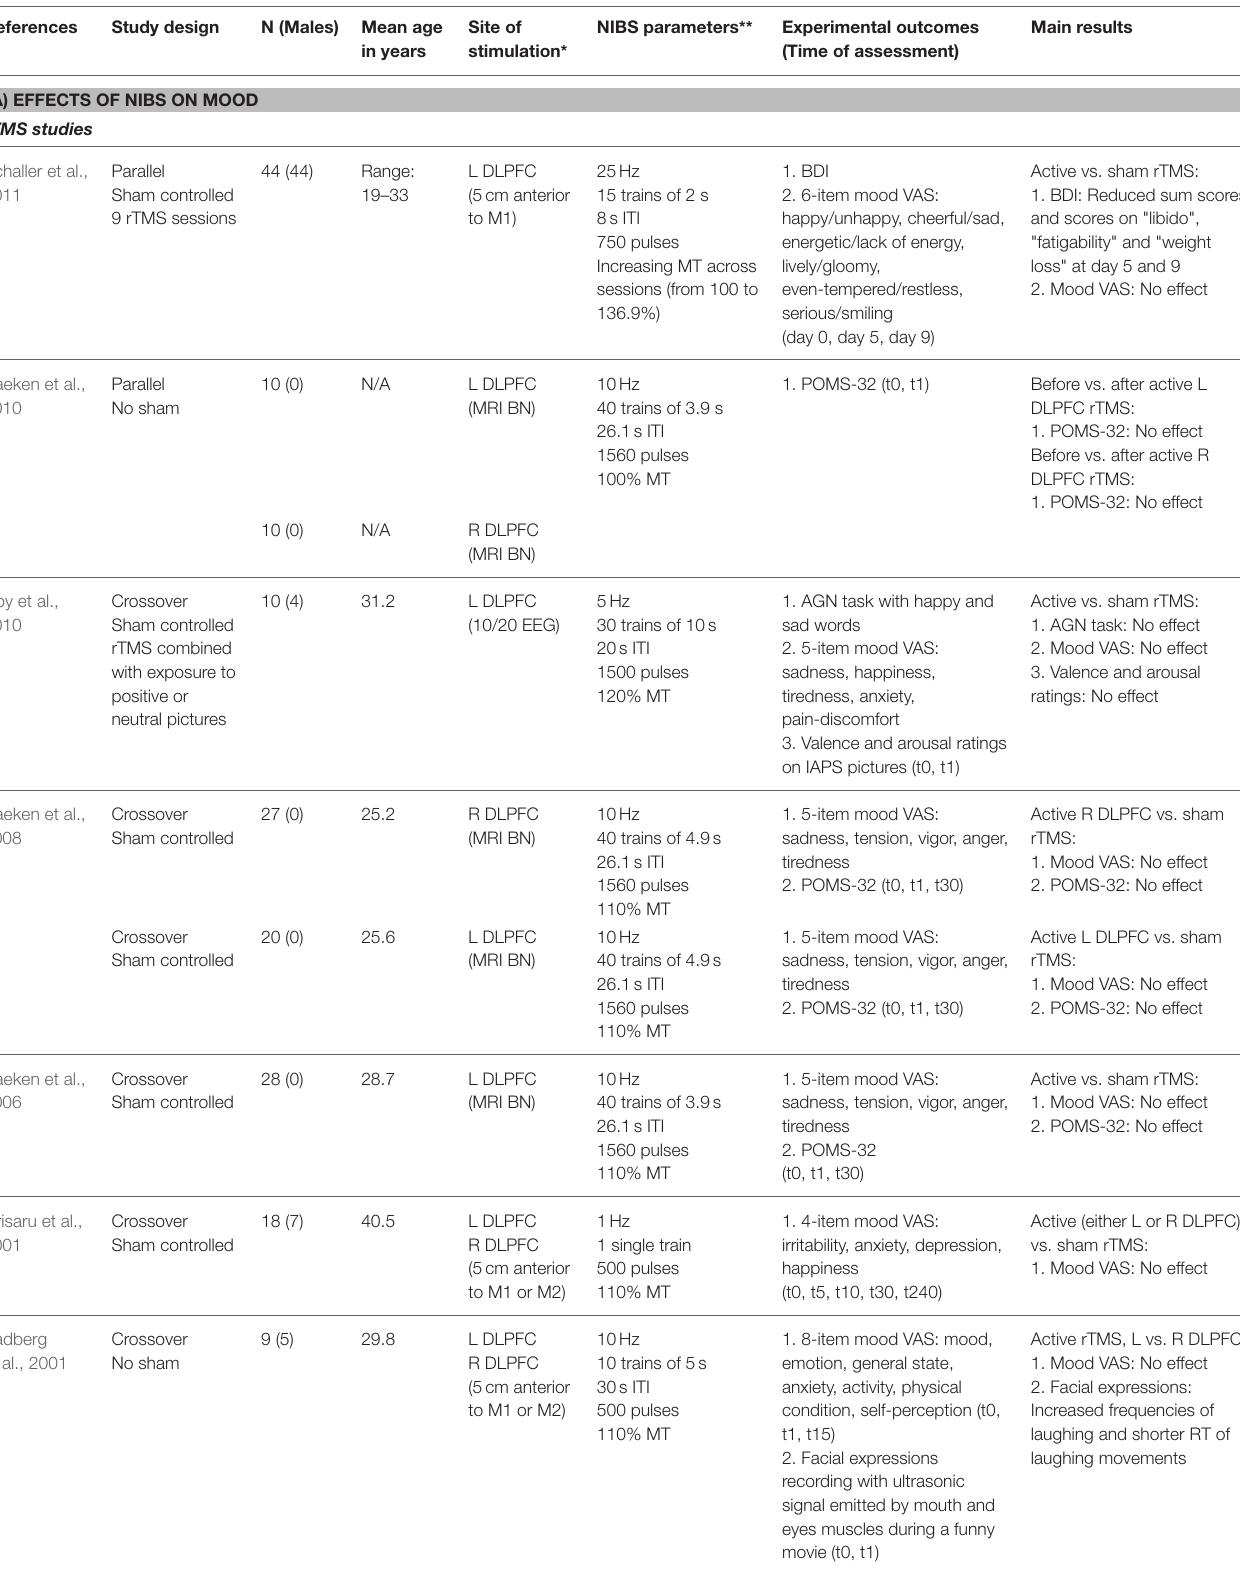
TABLE 1 | Summaries of the studies investigating the effects of non-invasive brain stimulation applied over the dorsolateral prefrontal cortex on mood, emotional processing, and attentional processing of emotional information in healthy